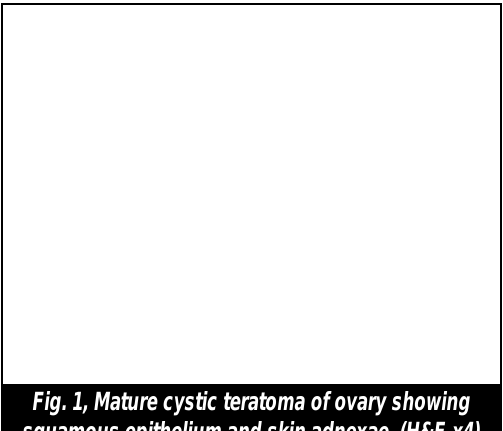
Fig. 1, Mature cystic teratoma of ovary showing squamous epithelium and skin adnexae.